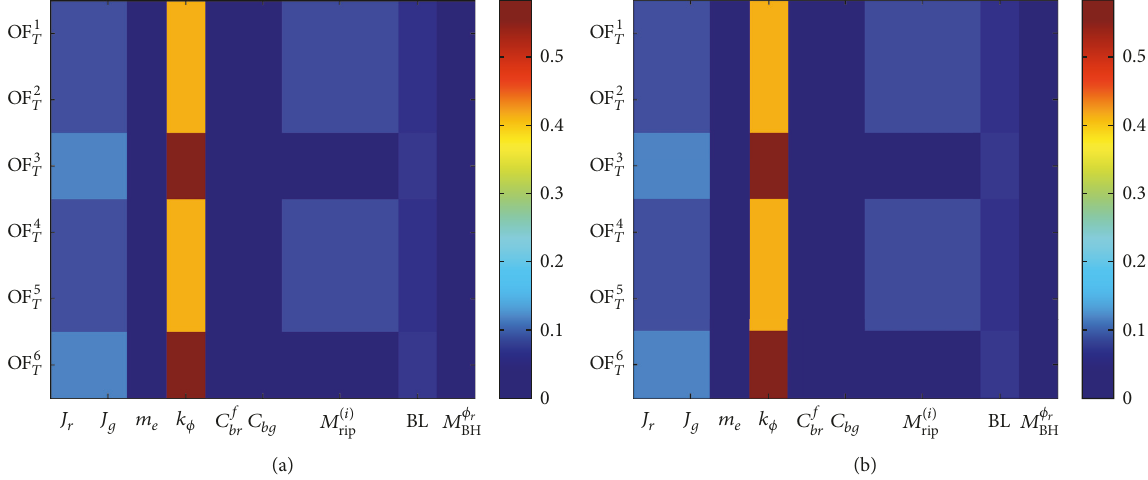
Figure 18: Primary sensitivity 𝑆 𝑖 (a) and total sensitivity ST 𝑖 (b) indices for torsional model for ℎ res